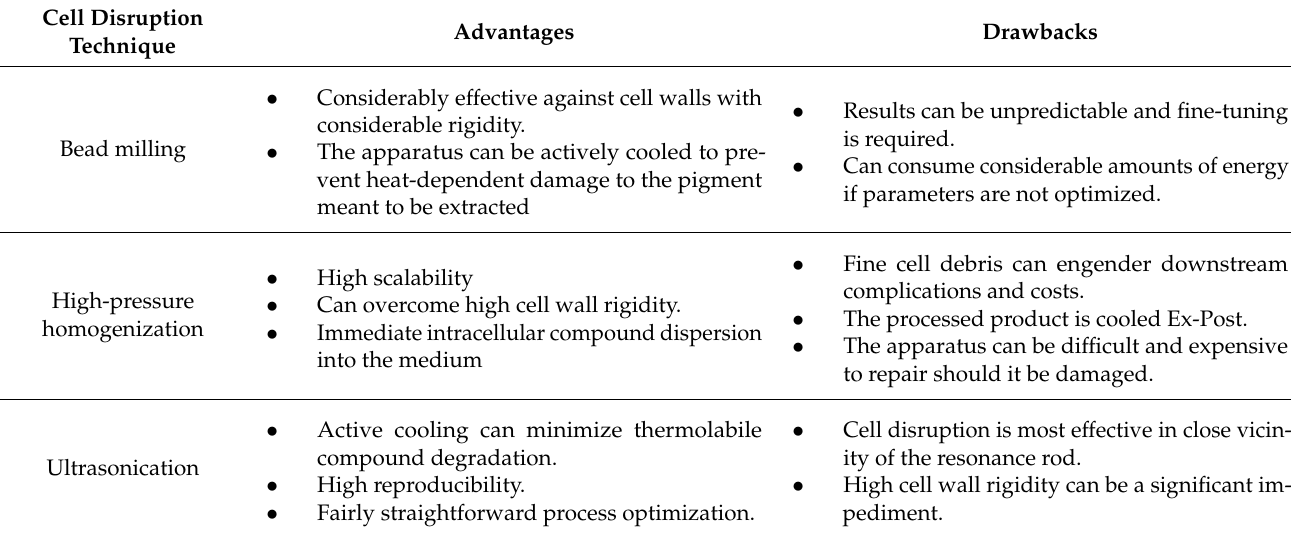
Table 1. Summary of the advantages and drawbacks of the reviewed mechanical extraction techniques, bearing in mind that they share the common shortcoming of producing significant heat. Cell Disruption Advantages Drawbacks Technique